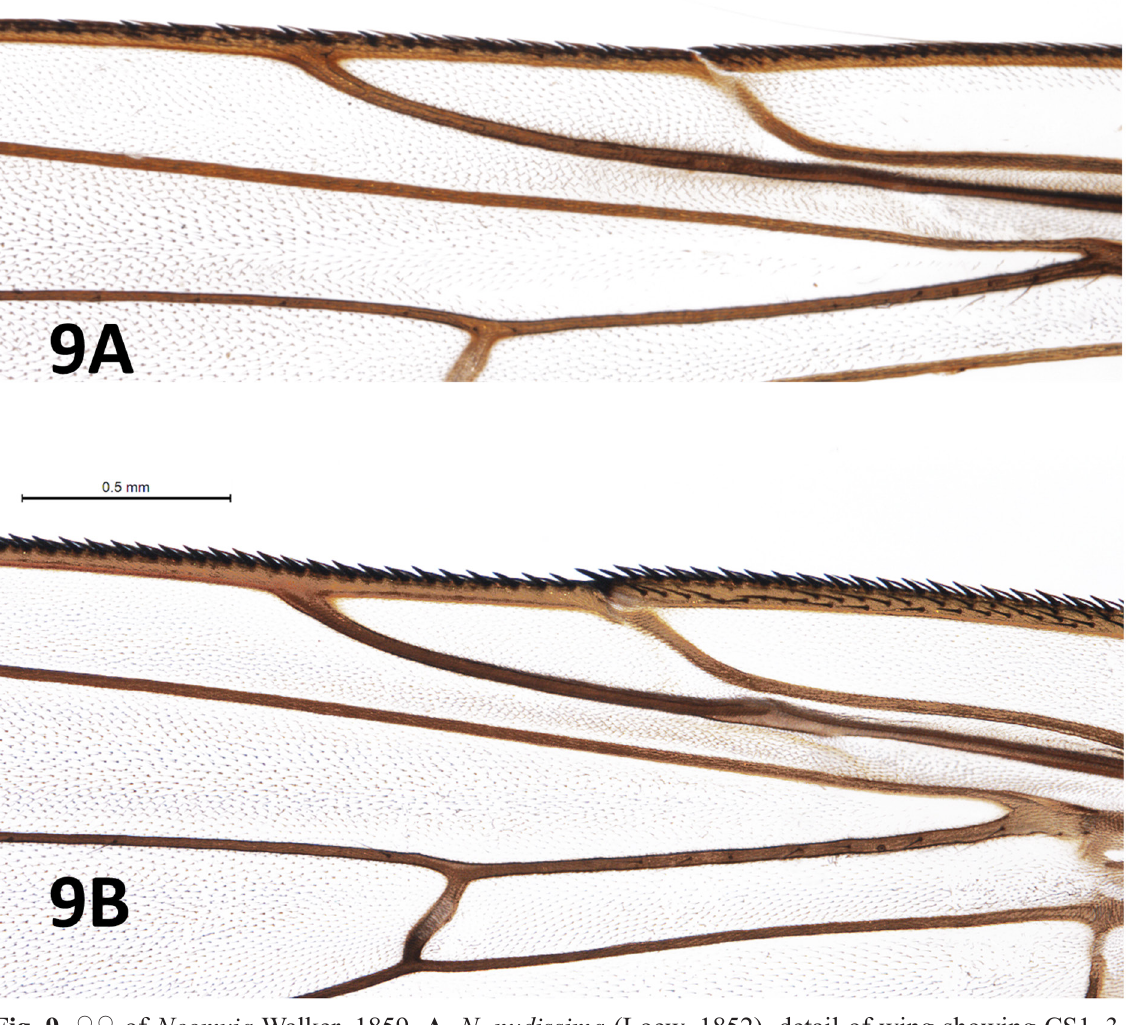
Fig. 9. ♀♀ of Neomyia Walker, 1859. A . N . nudissima (Loew, 1852), detail of wing showing CS1‒3, ventral view. B . N . cornicina (Fabricius, 1781), detail of wing showing CS1‒3, ventral